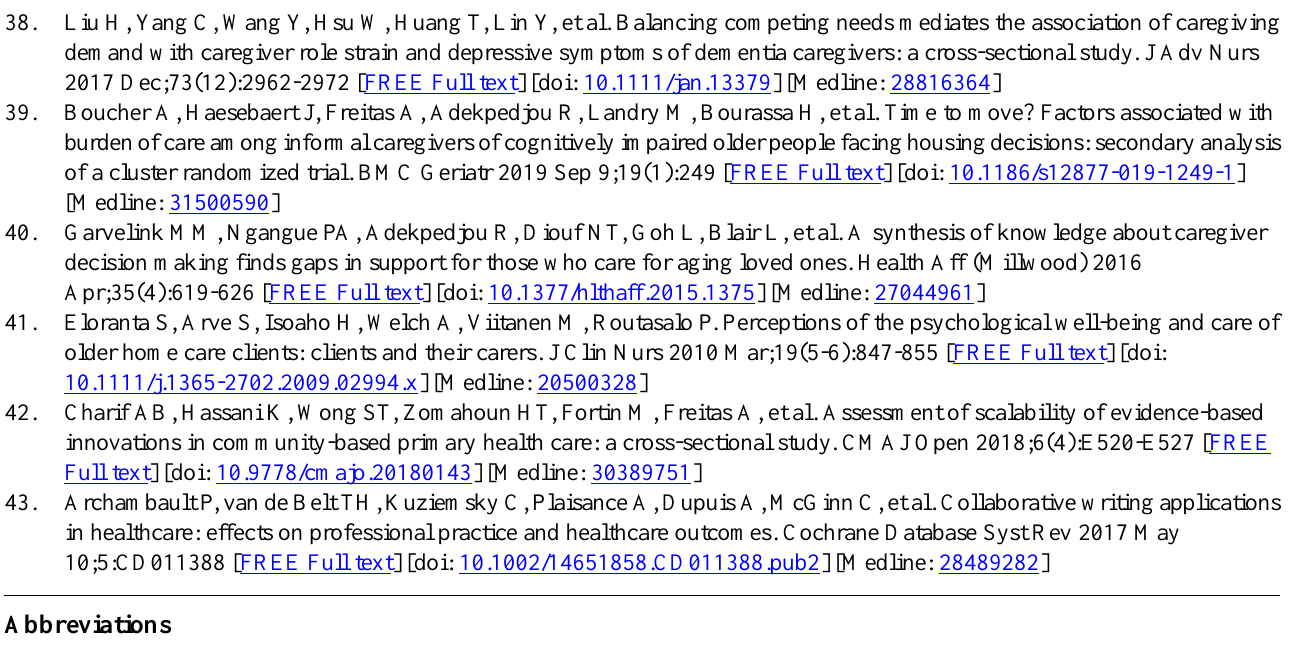
SPINACH: Supporting Seniors and Caregivers to Stay Mobile at